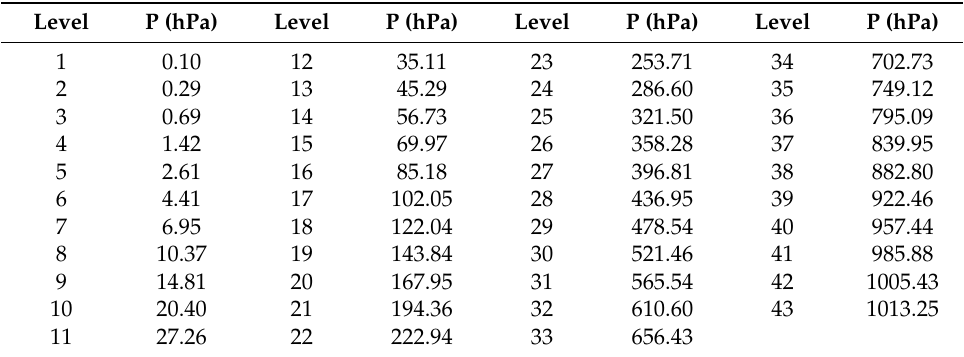
Table 1. Vertical coordinate defined by 43 pressure